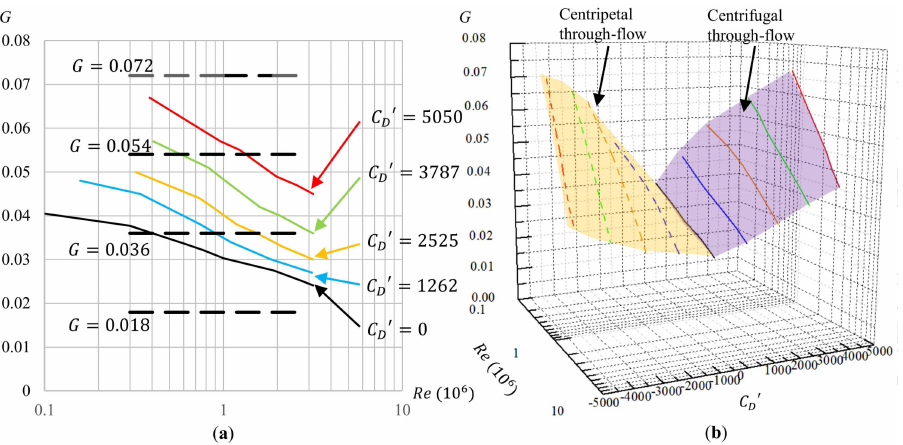
Figure 13. 3D Daily and Nece diagram: ( a ) Distinguishing lines and ( b ) Distinguishing surface. C D (cid:48) : through-flow coefficient; G: non-dimensional axial gap; Re: global circumferential Reynolds